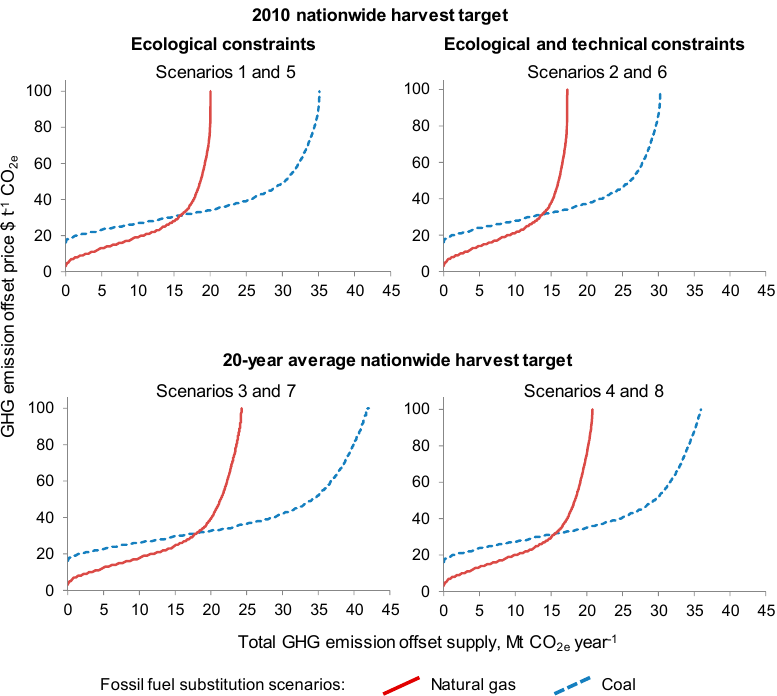
Figure 1. Nationwide greenhouse gas (GHG) emission offset supply curves for the baseline scenarios. Solid lines delineate the natural gas substitution scenarios and dashed lines show the coal substitution scenarios. See Table 1 for scenario descriptions.